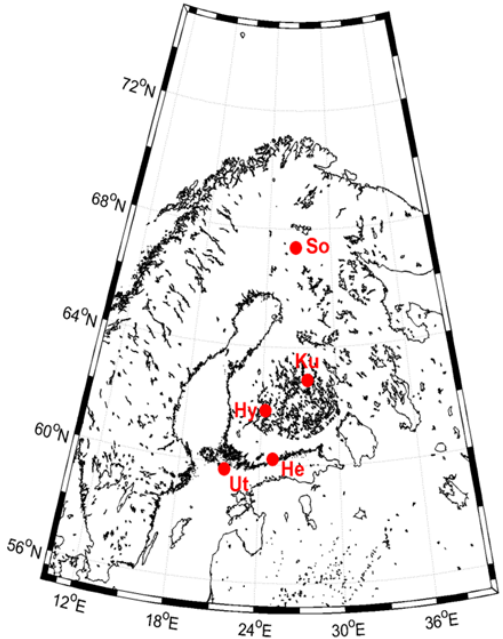
Fig. 1. Map of Finland indicating the network sites: So=Sodankylä, Ku=Kuopio, Hy=Hyytiälä, He=Helsinki and Ut=Utö.